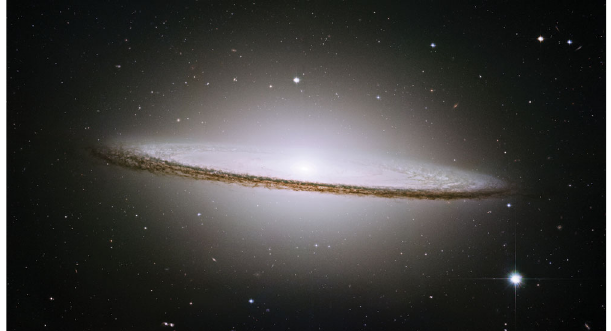
FIG. 4. Image of Sombrero Galaxy (M104), a lenticular galaxy located around 29 million light years away. Our understanding of cosmology and the scale of the Universe drastically altered when it was determined that objects (galaxies) like M104 were objects (galaxies) like the Milky Way, and not structures within the Milky Way itself. Image credit: HST/ESA/STScI.